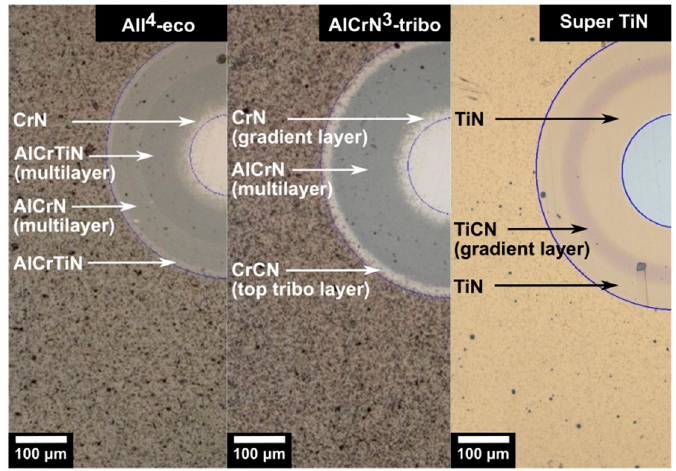
Figure 3. Structure of the tested coatings.